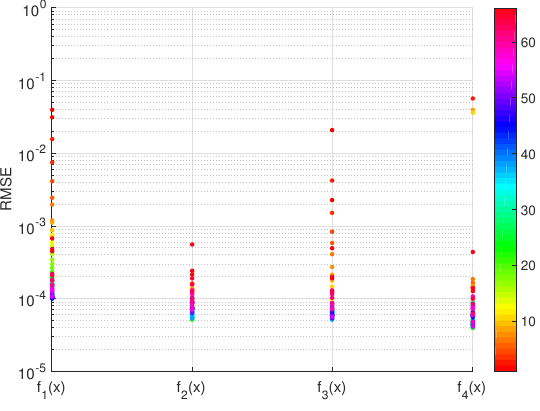
Figure 4. The RMSE of fitting functions f i ( x ) , i = 1,2,3,4 for all different numbers of ambiguities n . = 0.001 and the color bar indexes n The tolerable failure rate P tol f